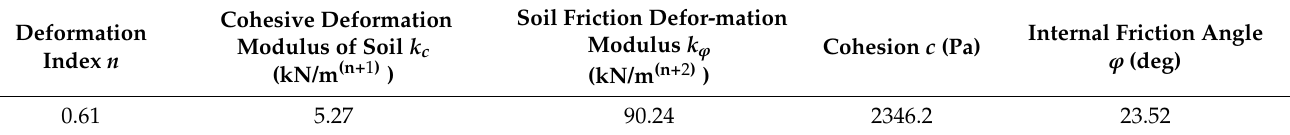
Table 2. Test parameters of field soil.